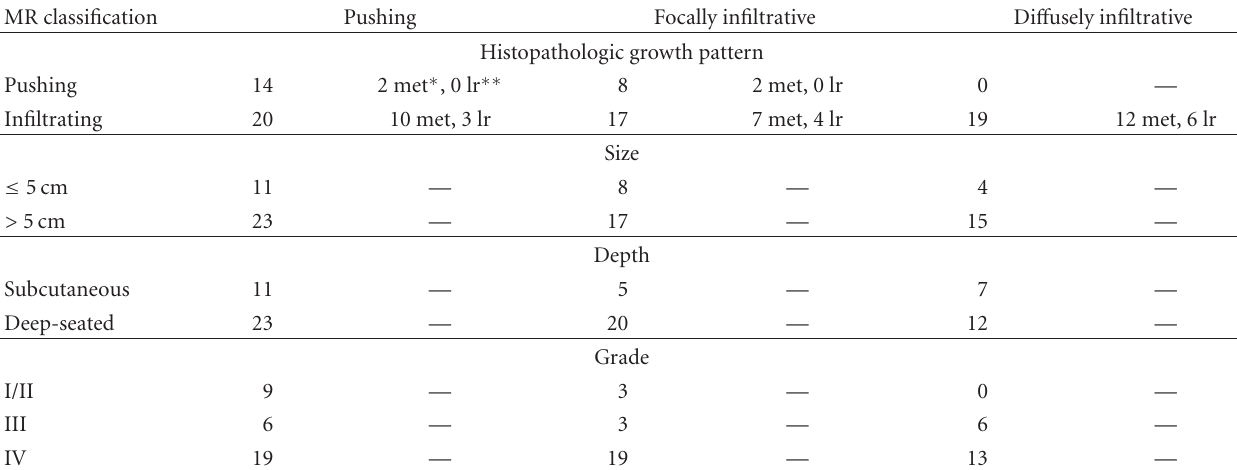
Table 2: Correlations between MR findings and clinicopathological data.